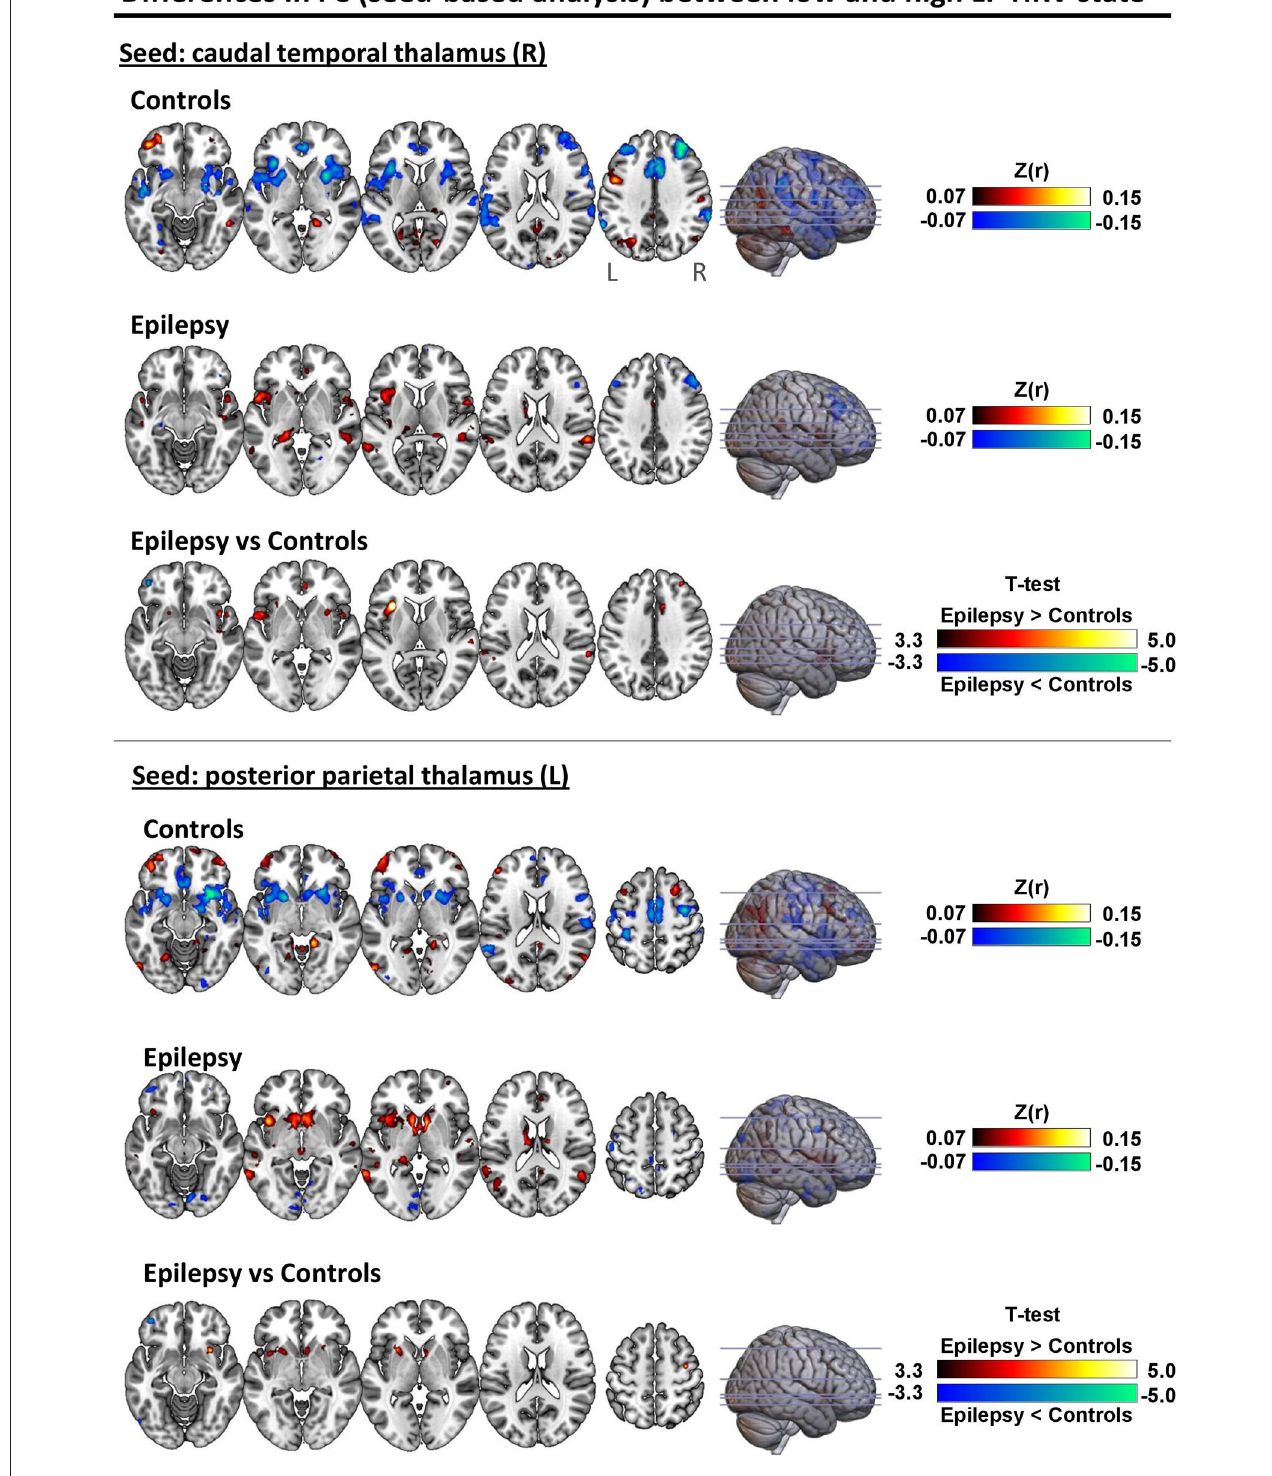
FIGURE 5 | Differences in seed-based FC between low and high LF-HRV state with seeds placed in the (top) right caudal temporal thalamus and (bottom) left posterior parietal thalamus. The first and second rows of each panel show the fisher-transformed correlations average across all healthy controls and epilepsy